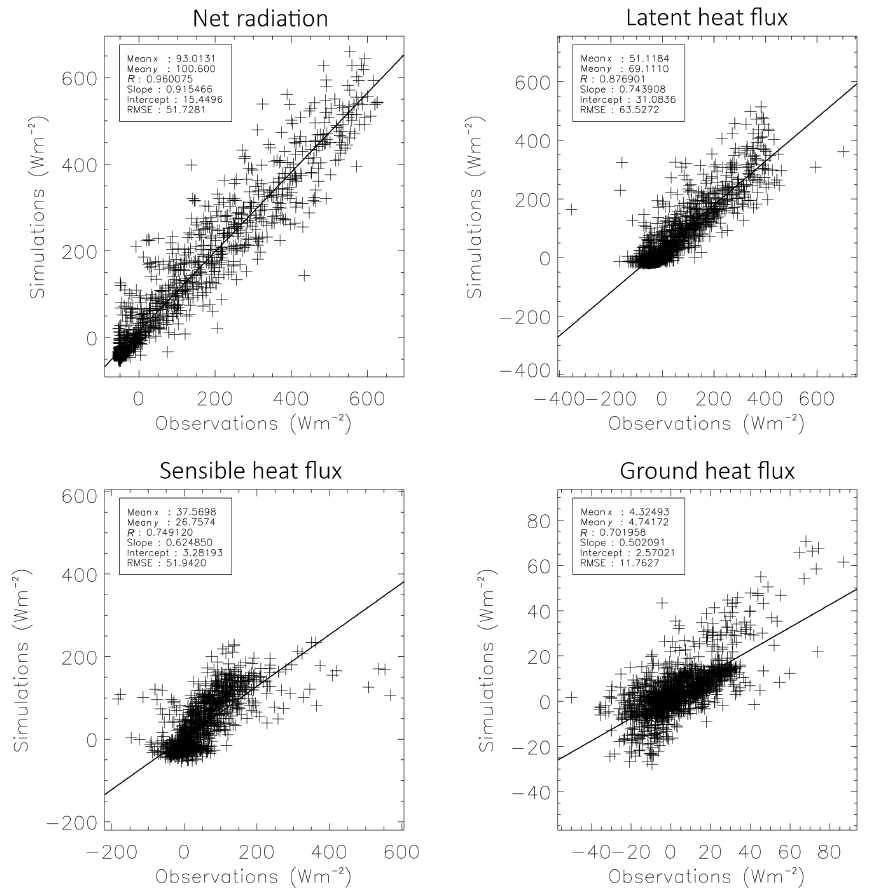
Figure 1. Comparison between the modeled and the observed energy balance terms for the simulation with (cid:49)z = 0.01m and a numerical solution of the heat conduction